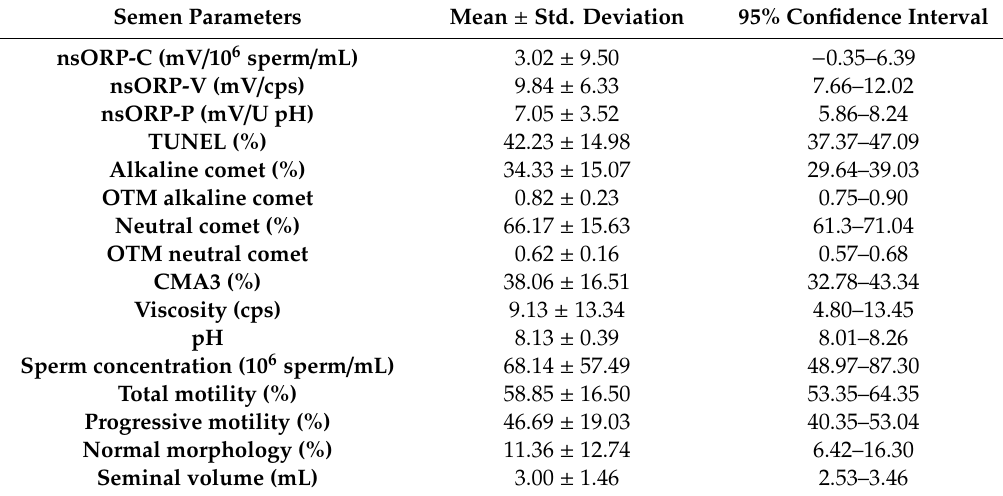
Table 2. Distribution of semen parameters in the studied patients.